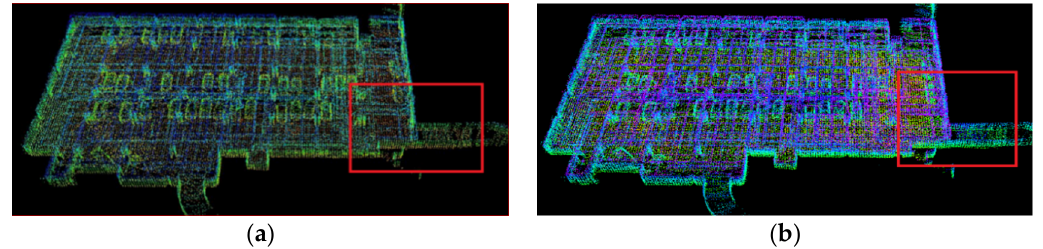
Figure 8. Point cloud map constructed for Scene 1: ( a ) by LeGO-LOAM; and ( b ) by LeGO-LOAM-SM.